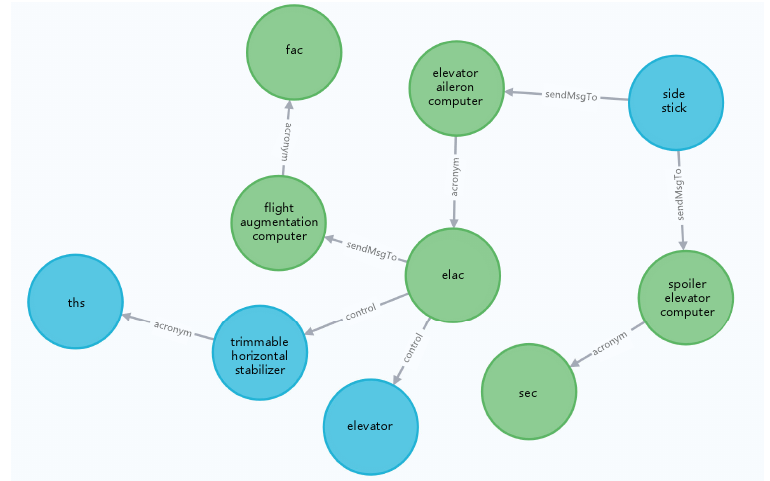
Figure 8. A case study of knowledge graph